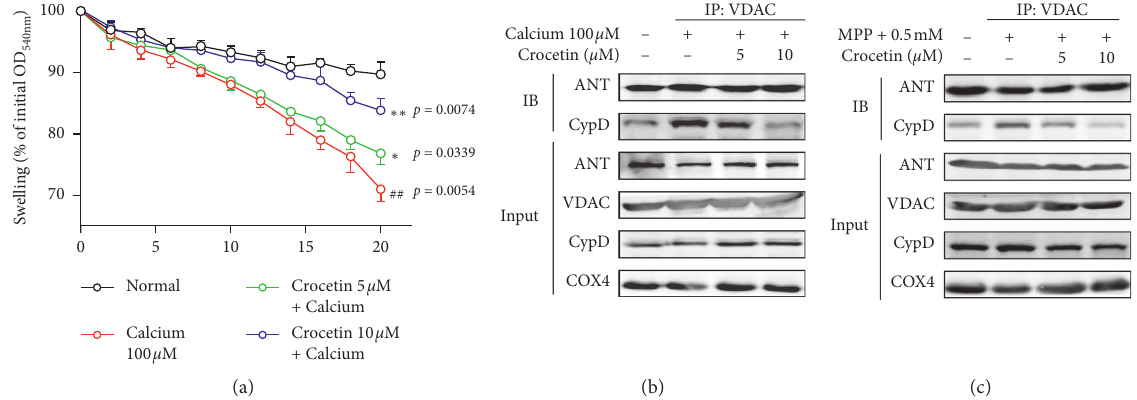
Figure 5: Crocetin blocks interaction between ANTand Cyp D to inhibit mPTP opening. (a) The curve is a typical sample of mitochondrial swelling induced by 100 μ M CaCl 2 . Mitochondrial swelling was measured by monitoring mitochondrial size at an absorbance of 540nm. 5 μ M and 10 μ M final concentrations of crocetin were added to the mitochondrial suspension for 5min before adding CaCl 2 . A change of absorbance within 20min with a spectrophotometer indicated mitochondrial swelling. (b) Isolated mitochondria were pretreated with crocetin for 5min followed by 100 μ M CaCl 2 for 20min, and then mitochondria were lysed and anti-VDAC antibody was added to pull down ANTand Cyp D. The levels of ANTand Cyp D pulled down by anti-VDAC were measured using immunoblotting. (c) BV2 cells were treated with 0.5 mM MPP+ for 6 h, and then 2.5 μ M, 5 μ M, and 10 μ M crocetin were added and incubated for another 24h. The ANT and Cyp D pulled down by VDAC were detected using immunoblotting. Data are expressed as mean ± standard deviation, and statistical analysis was performed using a one-way analysis of variance followed by Tukey’s post hoc test. ## P < 0 . 01 versus control; ∗ P < 0 . 05, ∗∗ P < 0 . 01 versus calcium